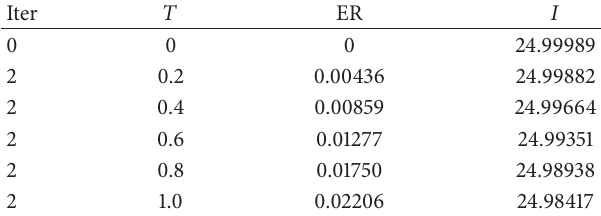
Table 2: Single soliton with 𝜎 = 1/6 .